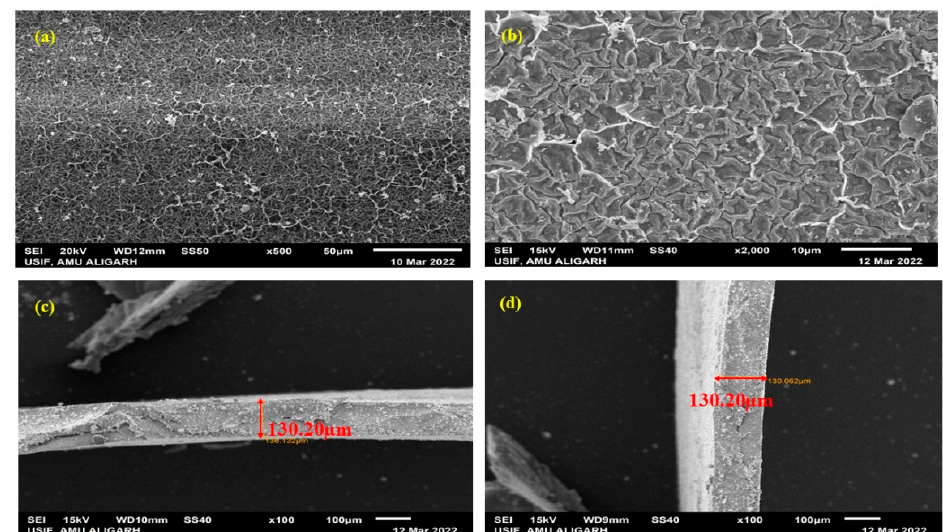
11 of 15 Figure 9. TGA curve of the SPVC–PTA–Pt IPMC membrane. 3.5. SEM Study Figure 10a–d show the surface and cross-sectional morphologies of the prepared SPVC–PTA–Pt IPMC membrane. Figure 10a,b, showing the surface morphology of the membrane at magnifications of 500× and 2000×, respectively, reveal the morphology of the self-assembled chains of the SPVC–PTA–Pt IPMC membrane. Meanwhile Figure 10c,d show the surface and cross-sectional views, respectively, at 100× magnification. The smooth texture at the membrane surface reflects the coating of the membrane surface with